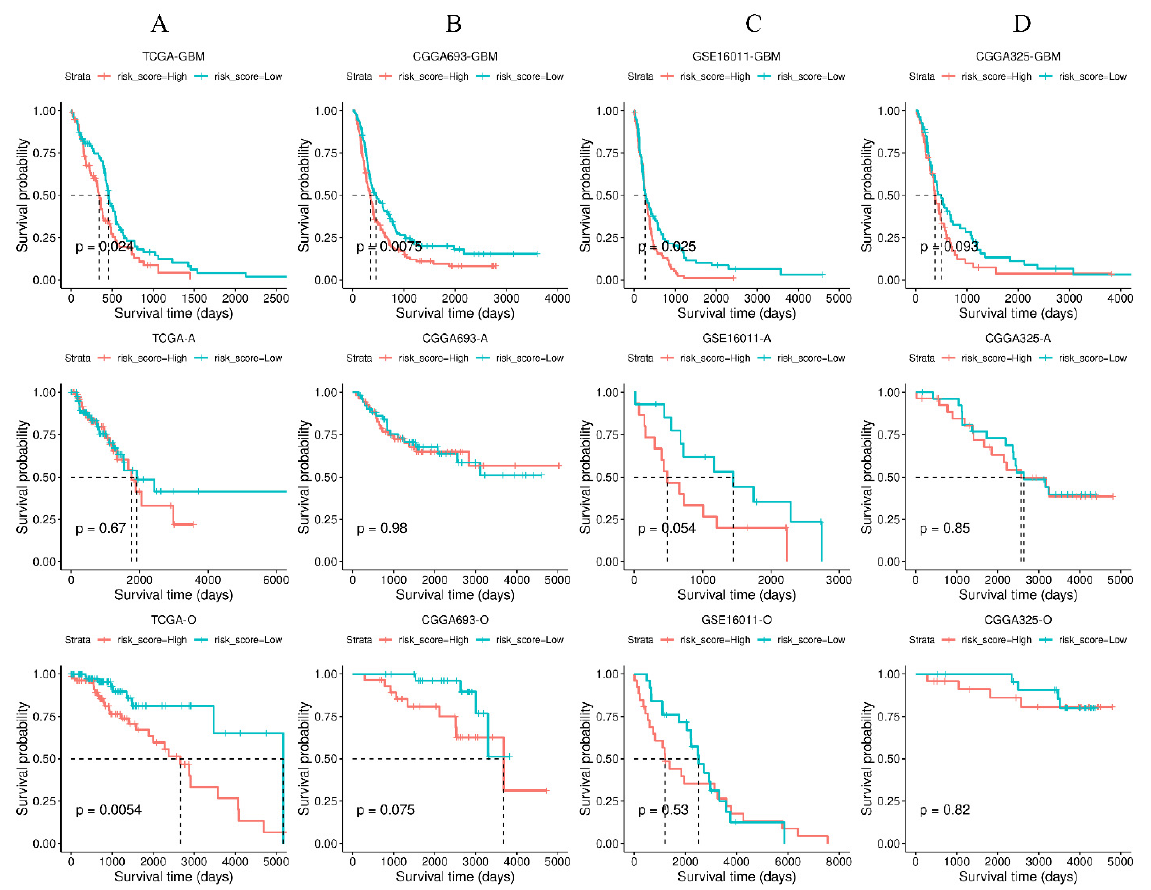
Figure 7. Kaplan–Meier curves of the four stiffness-dependent prognostic gene signatures for four independent cohorts: ( A ) TCGA, ( B ) CGGA_693, ( C ) GSE16011, and ( D ) CGGA_325. GBM: Glioblastoma, O: Oligodendroglioma, A: Astrocytoma.